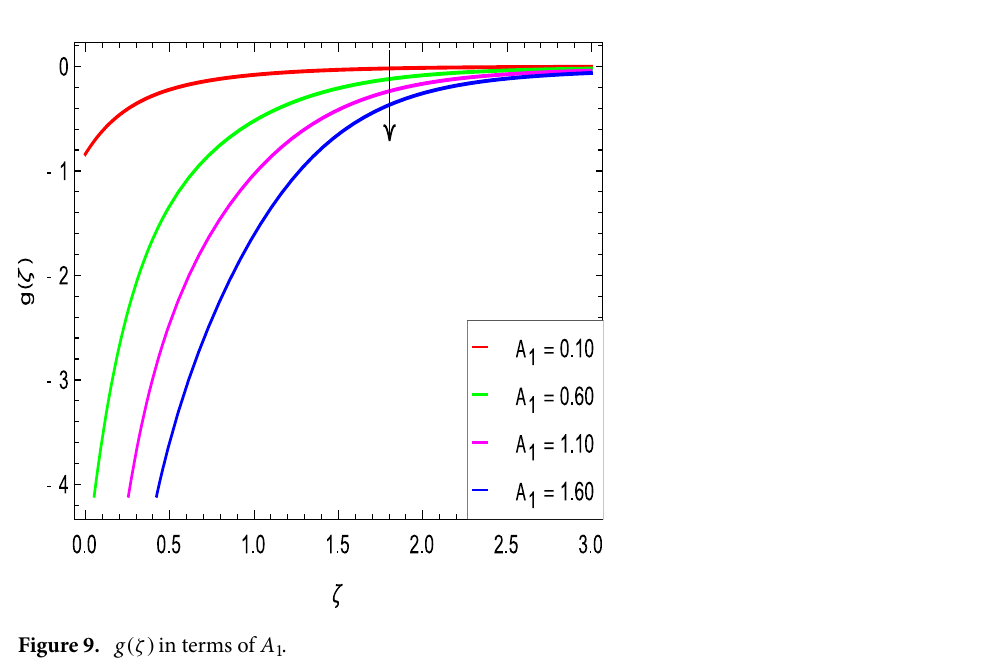
Figure 9. g (ζ) in terms of A 1